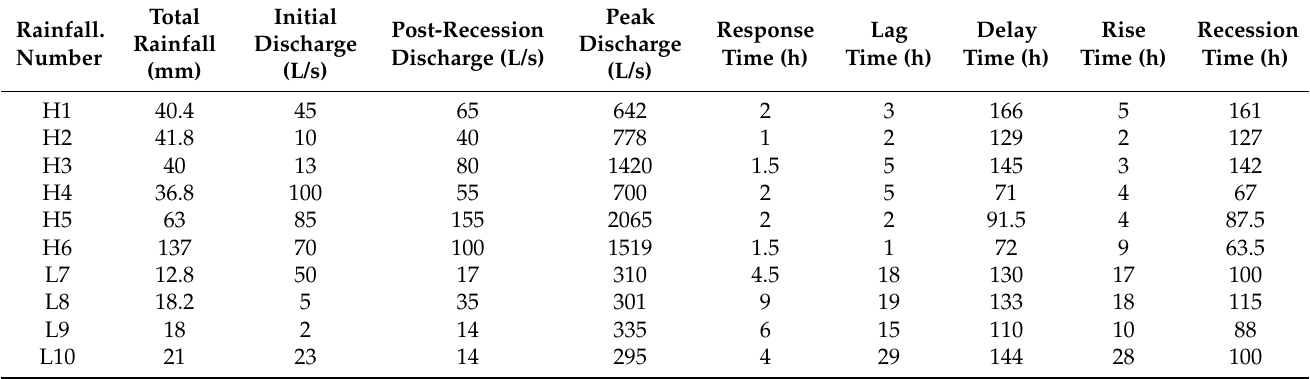
Table 3. Characteristic parameters of rainfall discharge curve.